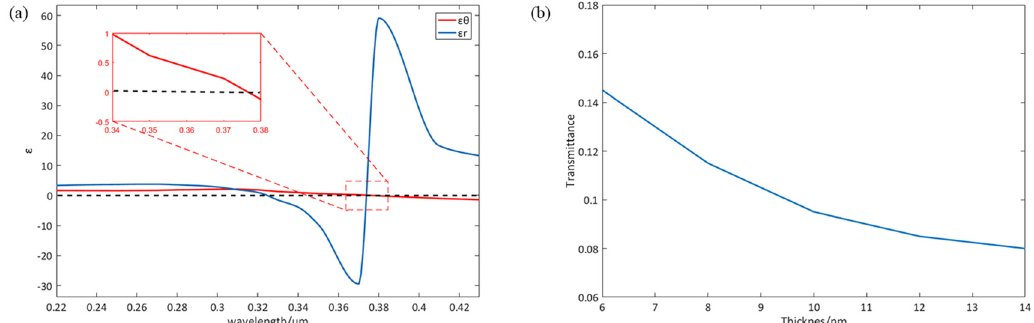
Figure 3. ( a ) Calculated (cid:2013) (cid:3045) and (cid:2013) (cid:3087) as a function of wavelength. ( b ) Different transmittances as a function of stacked-layer thickness.